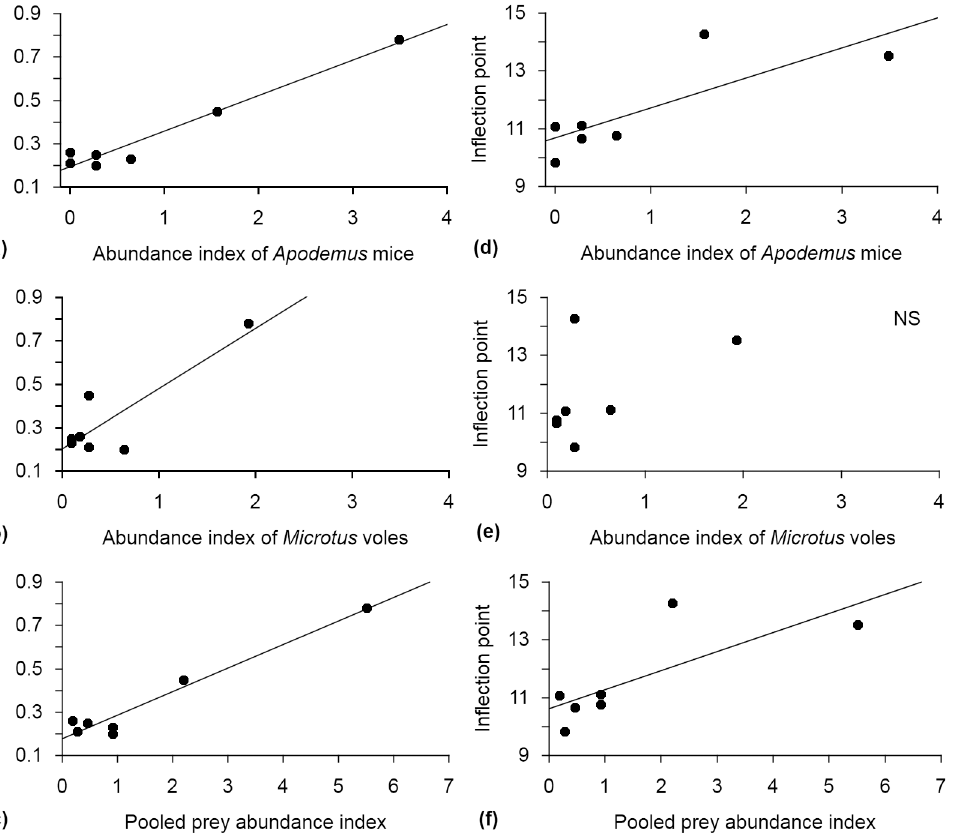
Fig 1. Relationships between the growth rate of Tengmalm ’ s owl nestlings and prey abundance index (number of individuals per 100 trap nights) of Apodemus mice (a), Microtus voles (b) and index of pooled prey abundance (c), and the relationship between the inflection point of Tengmalm ’ s owl nestlings and prey abundance index of Apodemus mice (d), Microtus voles (e) and index of pooled prey abundance (f). Lines denote curves fitted by